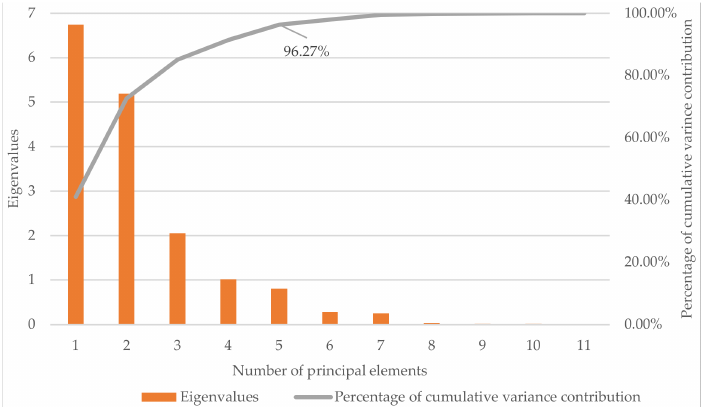
Figure 5. Cumulative variance contribution of the seismic attributes of kernel principal component analysis in the development stage.